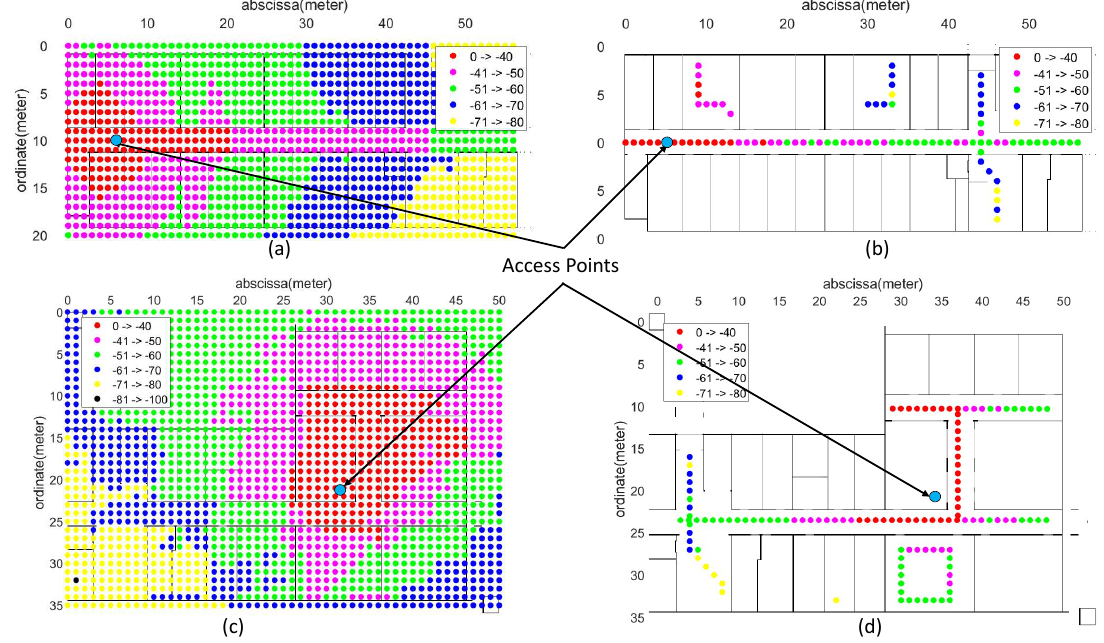
Figure 13. Comparison of 2-Dimensional radio maps of access points for both sites. ( a ) Estimated radio map and ( b ) Survey-based radio map for the ICE department. ( c ) Estimated radio map and ( d ) Survey-based radio map for CS